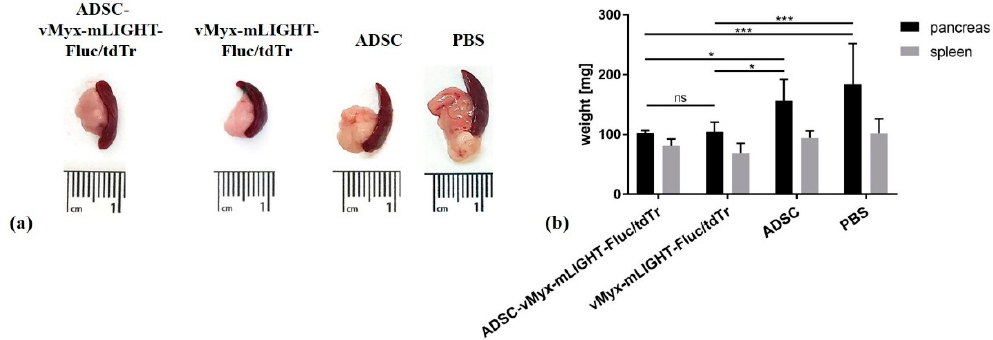
Figure 4. Inhibition of pancreatic adenocarcinoma formation after orthotopic implantation of Pan02 cells and consecutive injection of ADSC-shielded MYXV construct (vMyx-mLIGHT-Fluc/tdTr) or unshielded MYXV. ( a ) Macroscopic appearance of pancreas and spleen upon necropsy; ( b ) mass of pancreata and spleen ( n = 6) after orthotopic injection (21 days). The data show means ± SD of two independent experiments. (* p ≤ 0.05; *** p ≤ 0.001; ns—not significant)